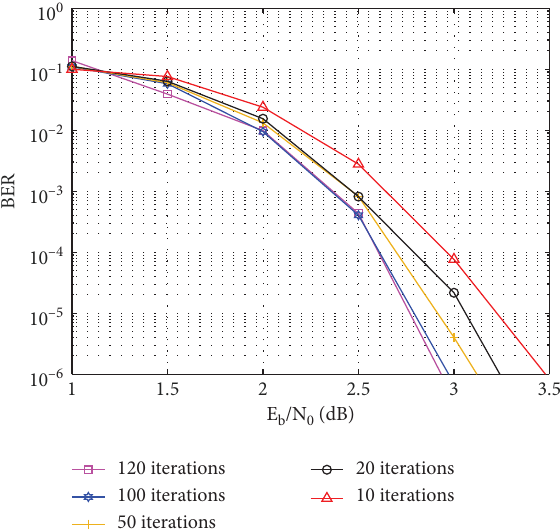
Figure 9: Infuence of diferent maximum numbers of iterations on MSA decoding for LDPC codes. n � 1008 and R � 1/2.